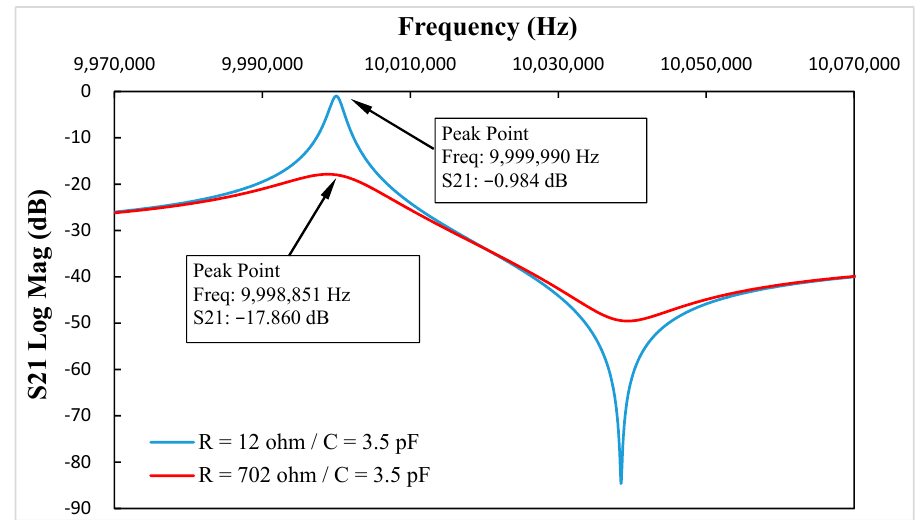
Figure 3. When C ∗ = 3.5 pF, the S21 parameters vs. frequency curve with and without added motional resistance.